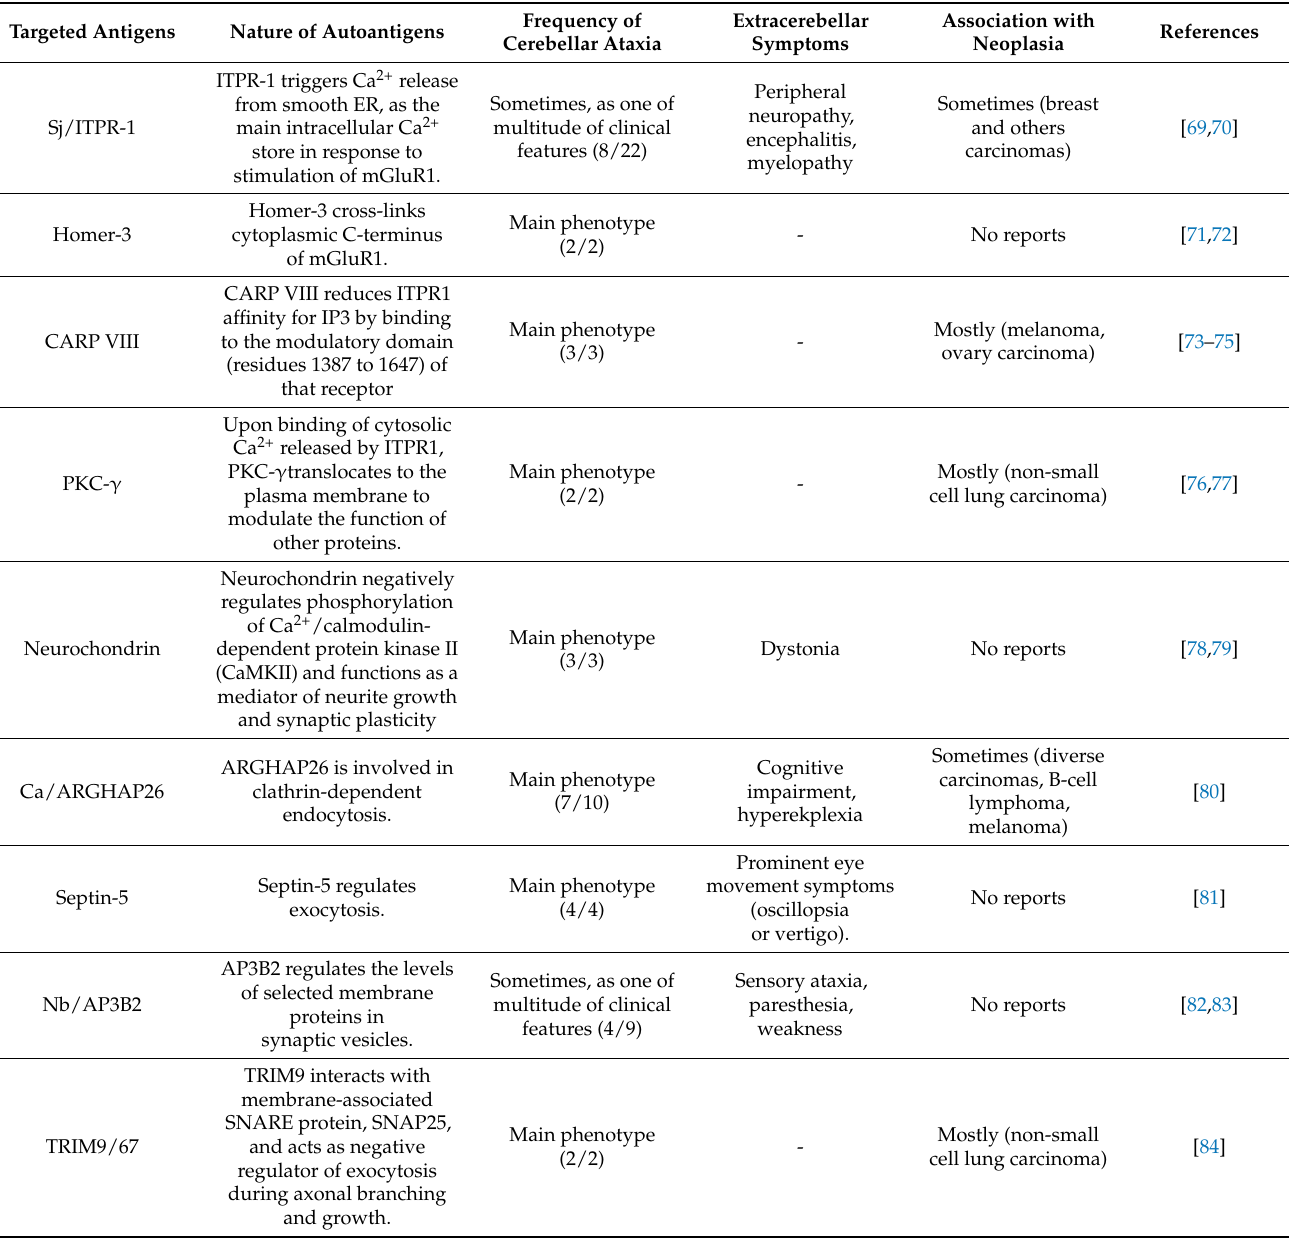
Table 3. Clinical features of primary autoimmune cerebellar ataxia associated with no characterized